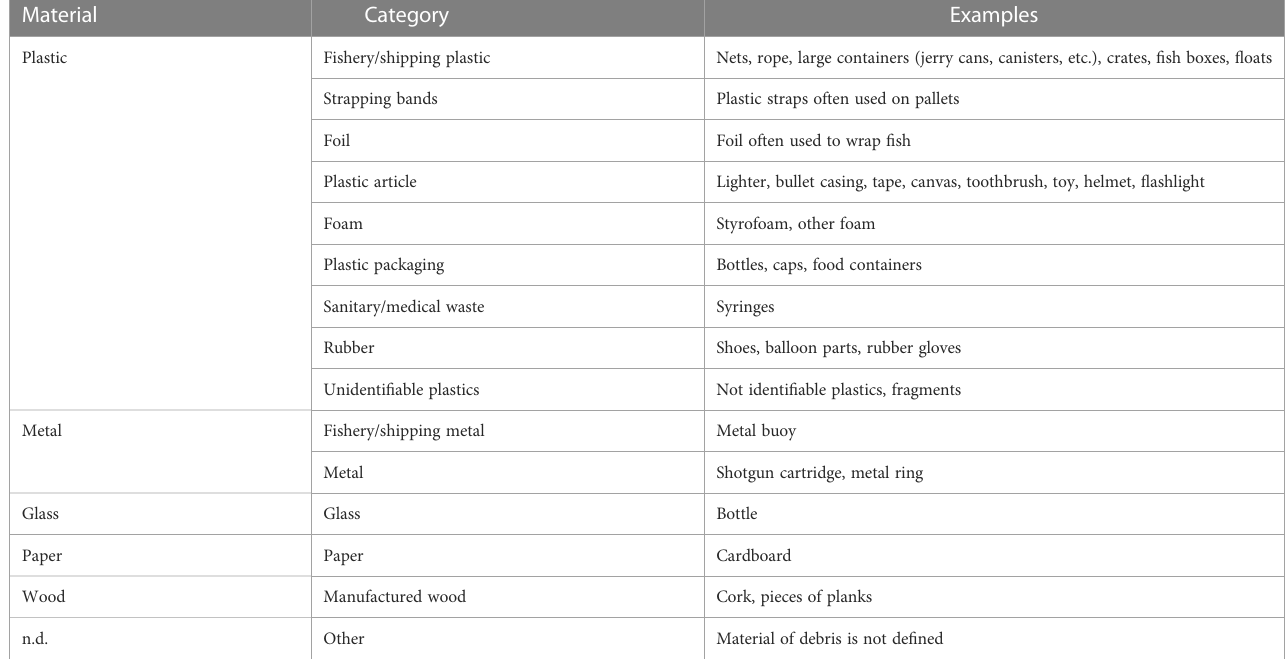
TABLE 4 Material and categorization of big pack debris, including examples (n.d. = not de fi ned).